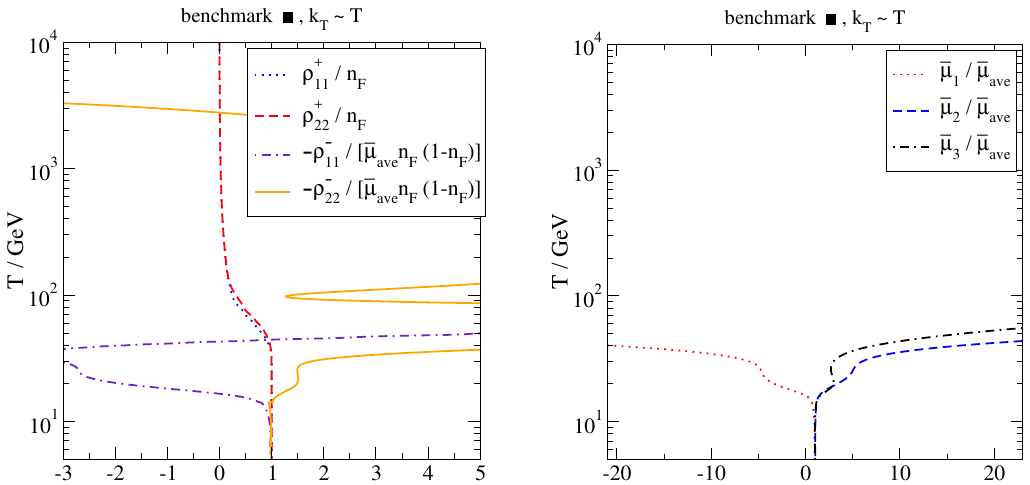
P (cid:17) 1 (cid:22) (cid:22) . The comoving ave a a 3